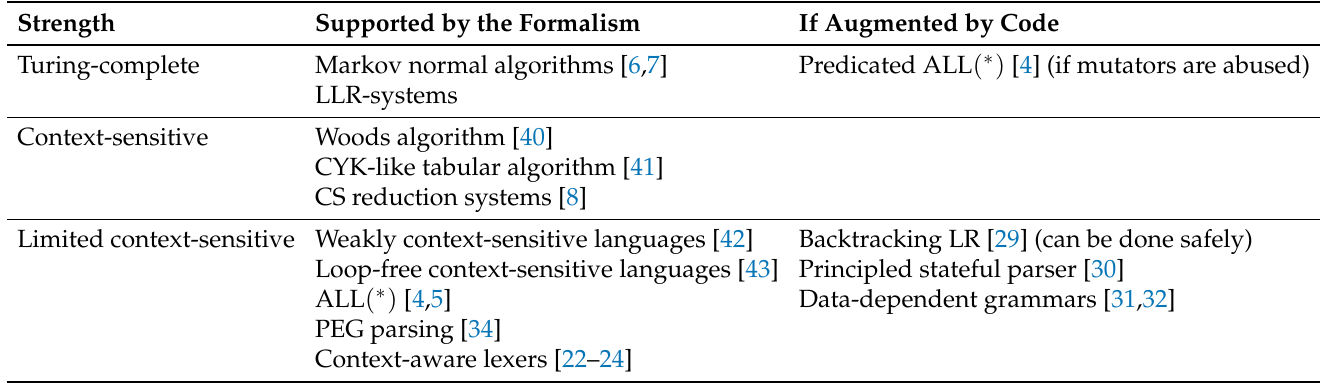
Table 1. Summary of different approaches for parsing non-context-free